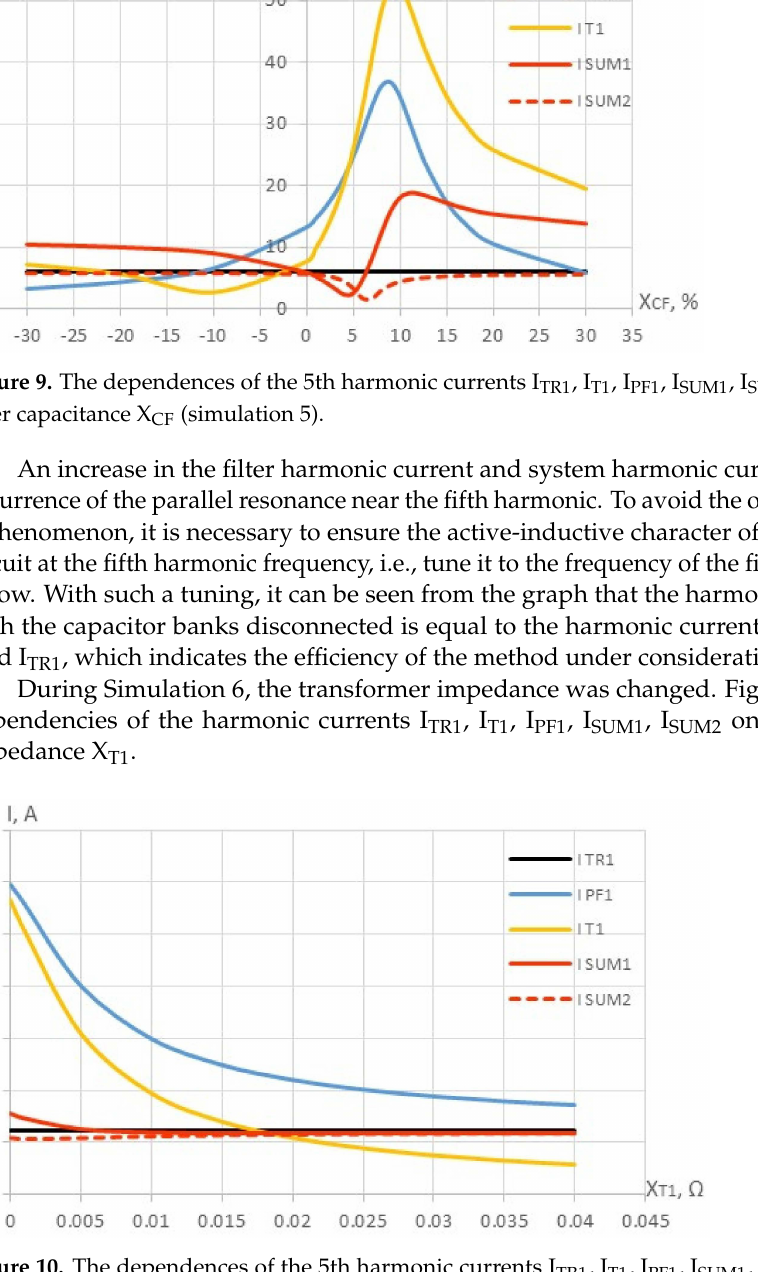
Figure 10. The dependences of the 5th harmonic currents I TR1 , I T1 , I PF1 , I SUM1 , I SUM2 on the trans- former impedance X T1 (simulation